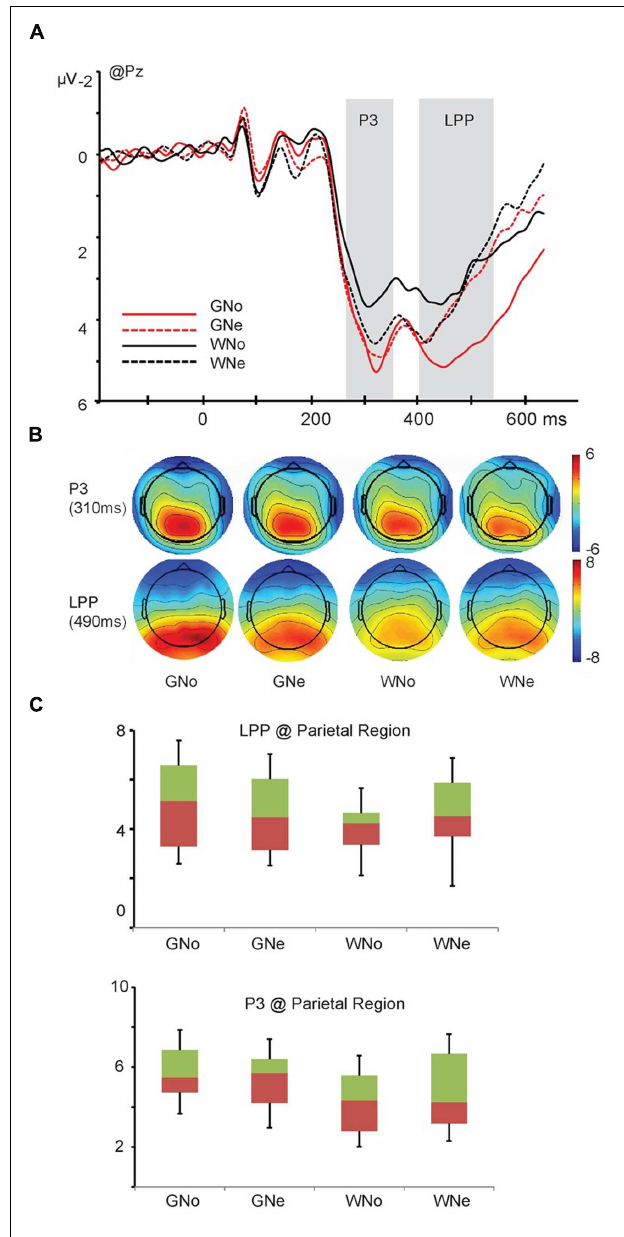
FIGURE 3 | (A) Grand average and voltage scalp map of P3 and late positive potential (LPP) component at Pz; (B) voltage scalp map of P3 and LPP components (C) the interaction of action × object of P3 and LPP components in the parietal